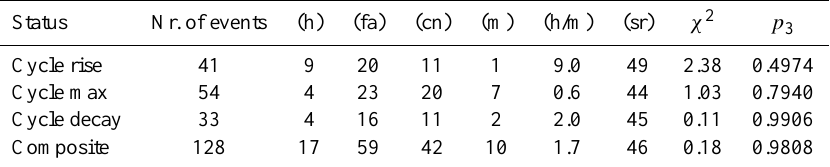
Table 5. Performance of the HAFv.2 model with respect to predicting SATs in association with a population of shocks with short ( τ ≤ 20min) proxy piston driving times during the key phases of solar cycle 23 and during the total